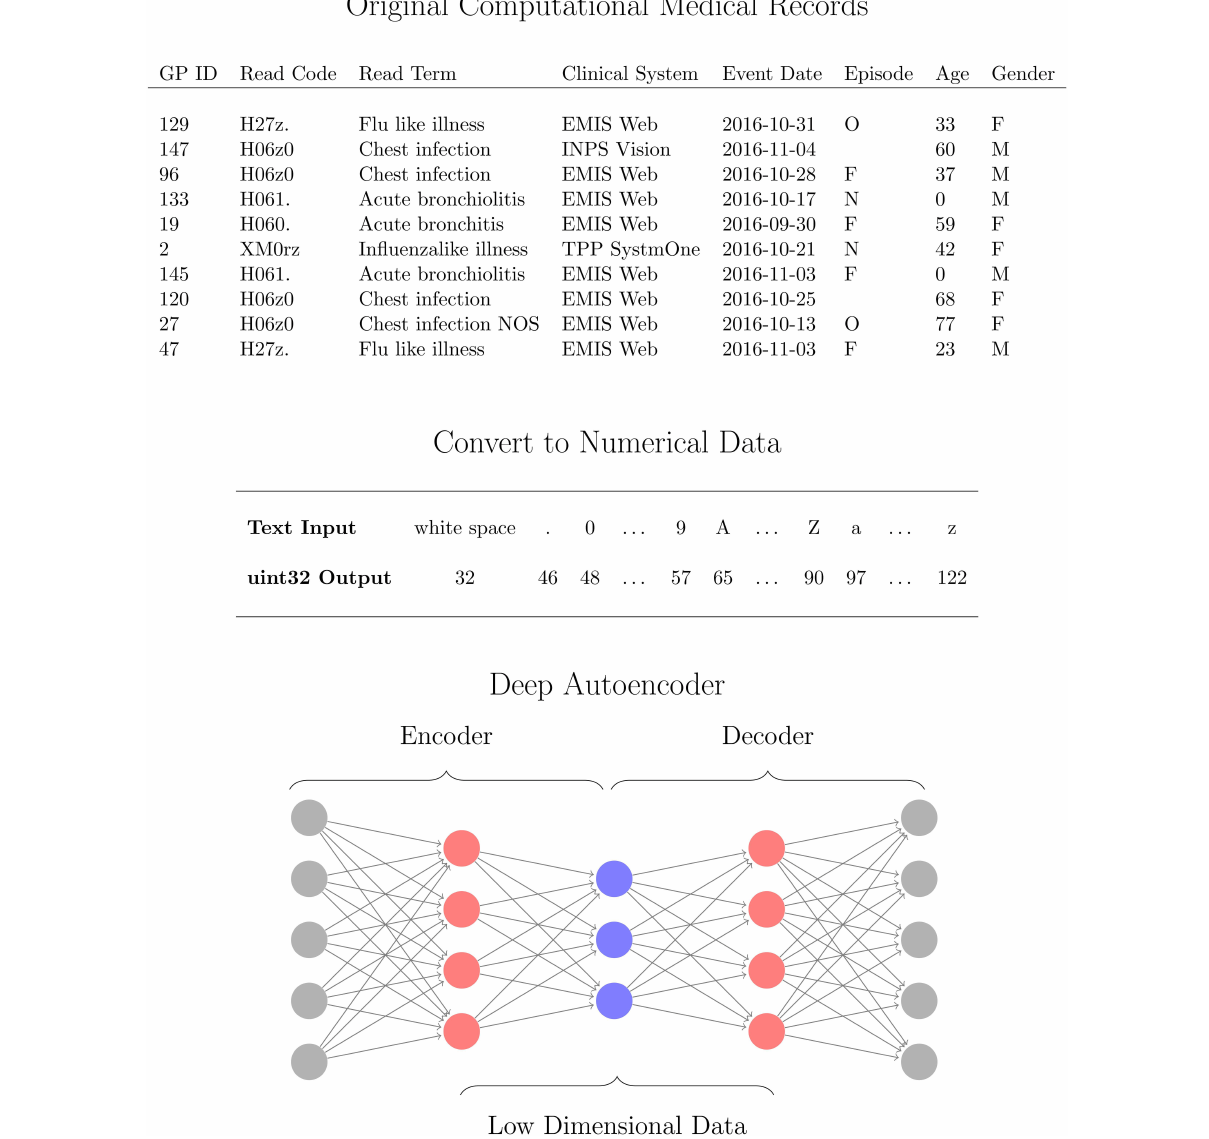
Frontiers in Applied Mathematics and Statistics |